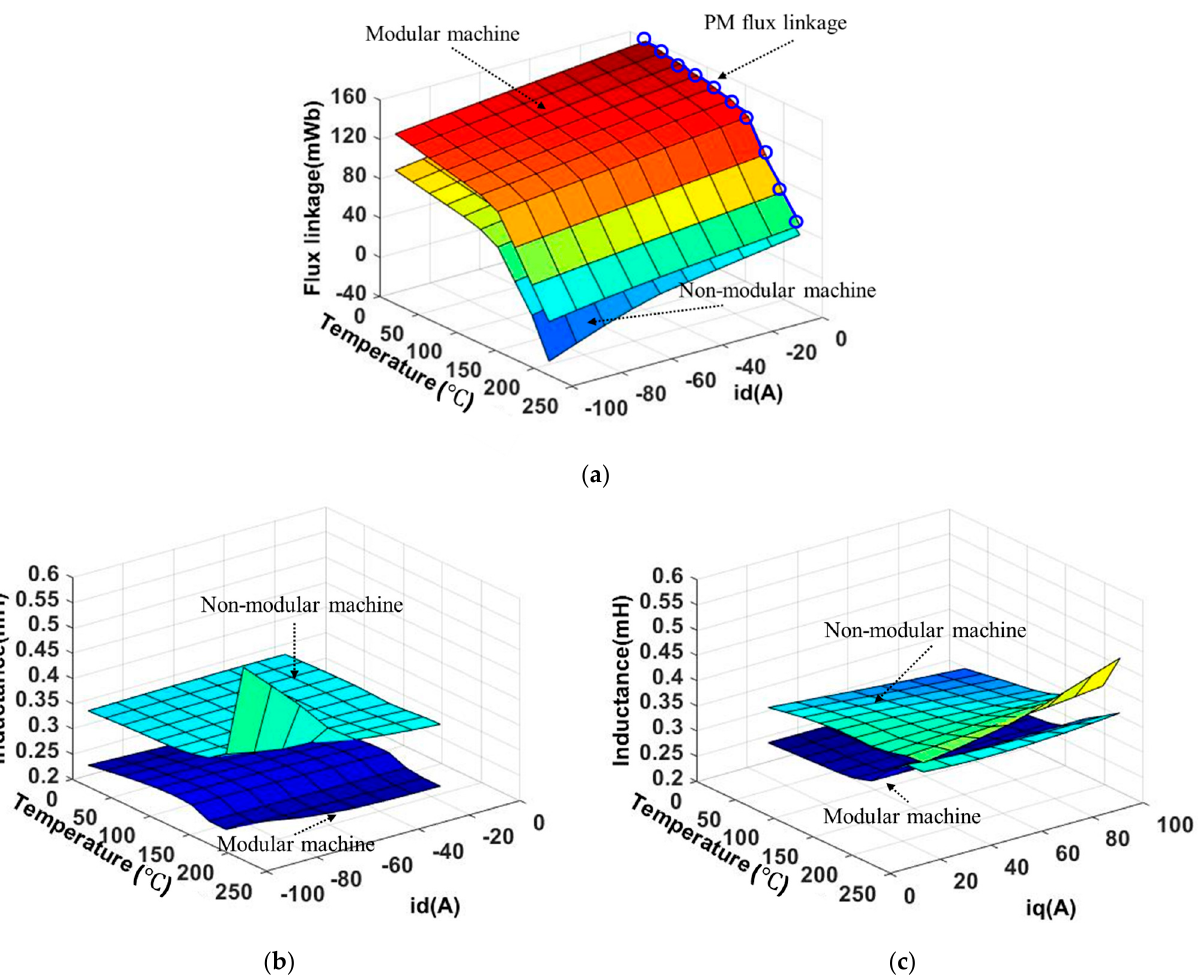
Figure 6. Temperature-dependent B(H) curves for PM material used in this paper.